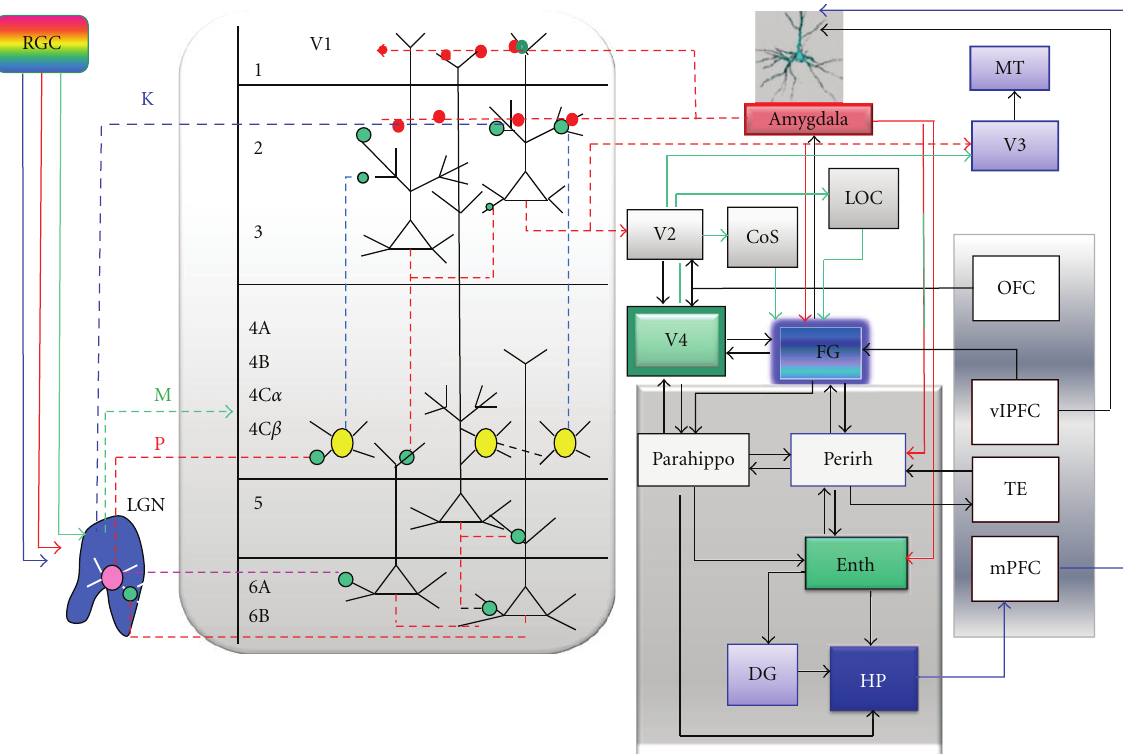
Figure 2: Visual signal processing along the ventral visual stream. Photons reflected from the object surface traverse first three retinal cell layers to reach photoreceptor-containing cones and rods. Retinal image formation relies mainly on di ff erential glutamate signalling by ON and OFF cones [19, 40]. Local calculations performed by dendritic branches of direction-selective retinal ganglion cells (RGC) and asymmetric nature of synaptic inhibitory inputs from starburst amacrine cells assure high fidelity of object image formation at the retina [41]. Each pixel of the retinal image gets transmitted via dedicated RGC axons to the lateral geniculate nucleus (LGN). Propagating action potentials excite parvocellular LGN neurons (P), which synapse onto stellate cells of V1 (4C layer, yellow) [19]. Direct koniocellular a ff erents (K) from LGN to L2/3 inform our brain about the relative retinal image displacement (object movement) and activate the dorsal visual stream targeting the orbitofrontal cortex (OFC) [24]. OFC sends rich cholinergic top-down a ff erents to visual cortex [42, 43] and helps to maintain attention load exercised on V1–V4 areas. The layer L2/3 neurons of V2 send horizontal axonal projections to V4 area, which serve as visual short-term memory bu ff er [44]. Early visual cortex communicates with fusiform gyrus (FG) and amygdala nuclei of both hemispheres. Primate amygdala projects axons equipped with bouton terminals (dotted red lines and circles) onto dendritic spines located in L1 and L2 layers of V1 [45]. Amygdala-induced neurotransmitter release at the axo-spinous synaptic contacts visual brain areas facilitates formation of visual long-term memories, especially those of high emotional dimension. CoS—collateral sulcus, LOC—lateral occipital cortex, Perirh— perirhinal cortex, Enth—entorhinal cortex, Parahippo—parahippocampal gyrus, DG—dentate gyrus, Hp—hippocampus, vlPFC—ventro- lateral prefrontal cortex, mPFC—medial prefrontal cortex, and TE—temporal